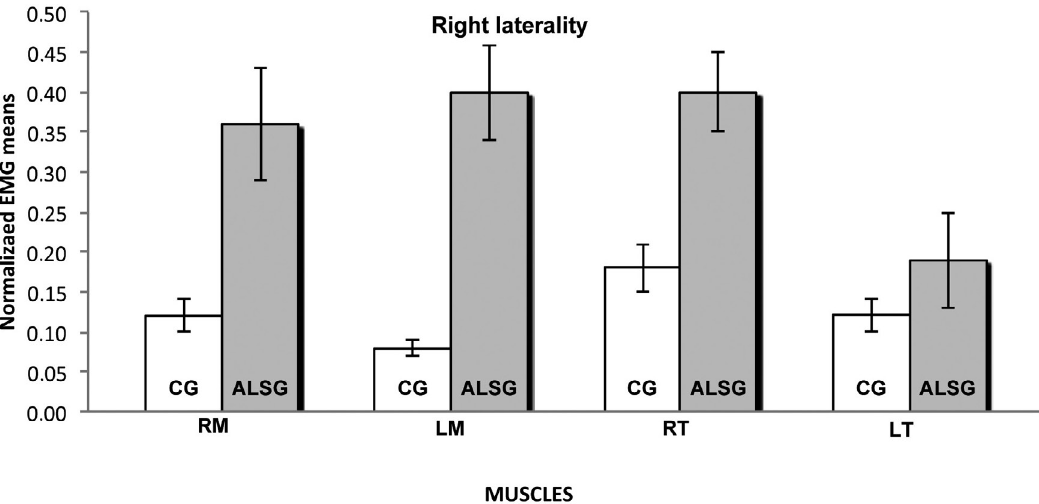
Figure 2- Normalized electromyography data of masseter (RM: right masseter; LM: left masseter) and temporalis (RT: right temporal; LT: left temporal) muscles for CG and ALSG in the right laterality